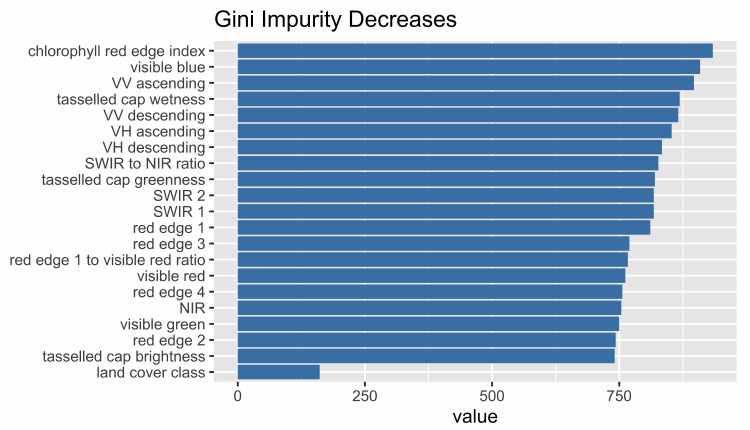
Figure 8. The sum of the Gini impurity decreases across all node splits for each individual random forest feature. The bars represent the importance of each feature, measured through the sum of all the Gini impurity index decreases for each feature included in the random forest